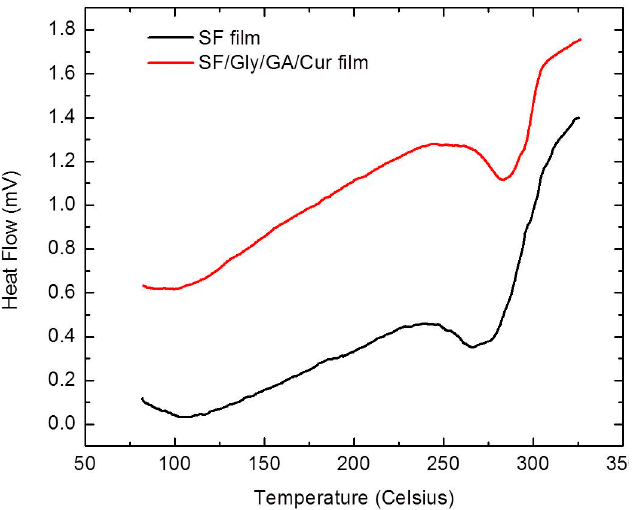
/ Gly / GA / Cur composite